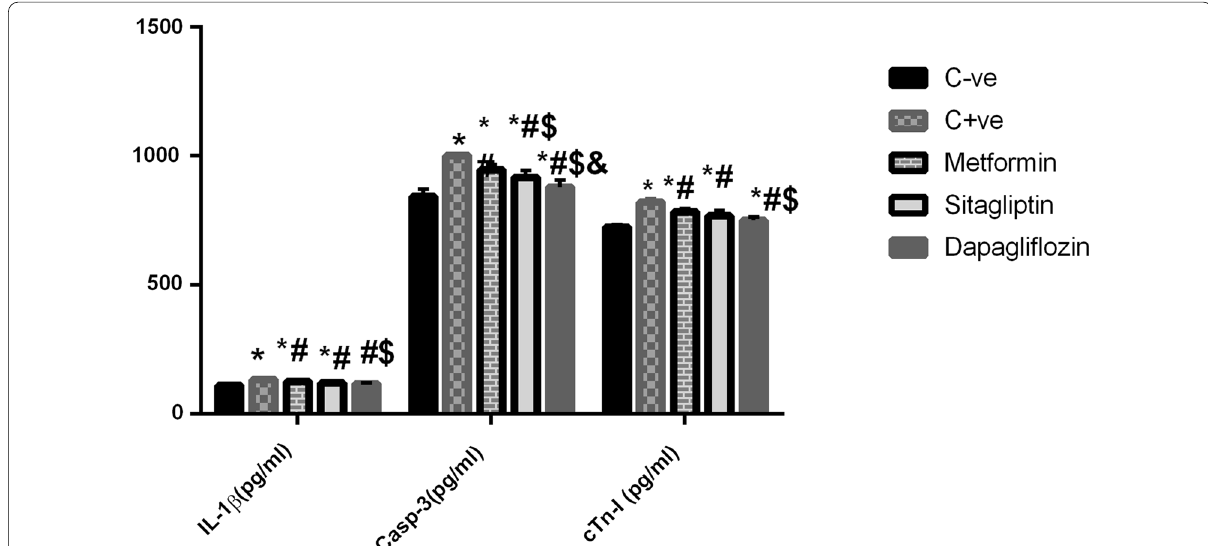
Fig. 4 Biochemical laboratory estimates among different studied groups *: Significant between normal control and each other group, #: Significant between C ve and each other group, $: Significant between Metformin and each other group and &: Significant between Sitagliptin and +